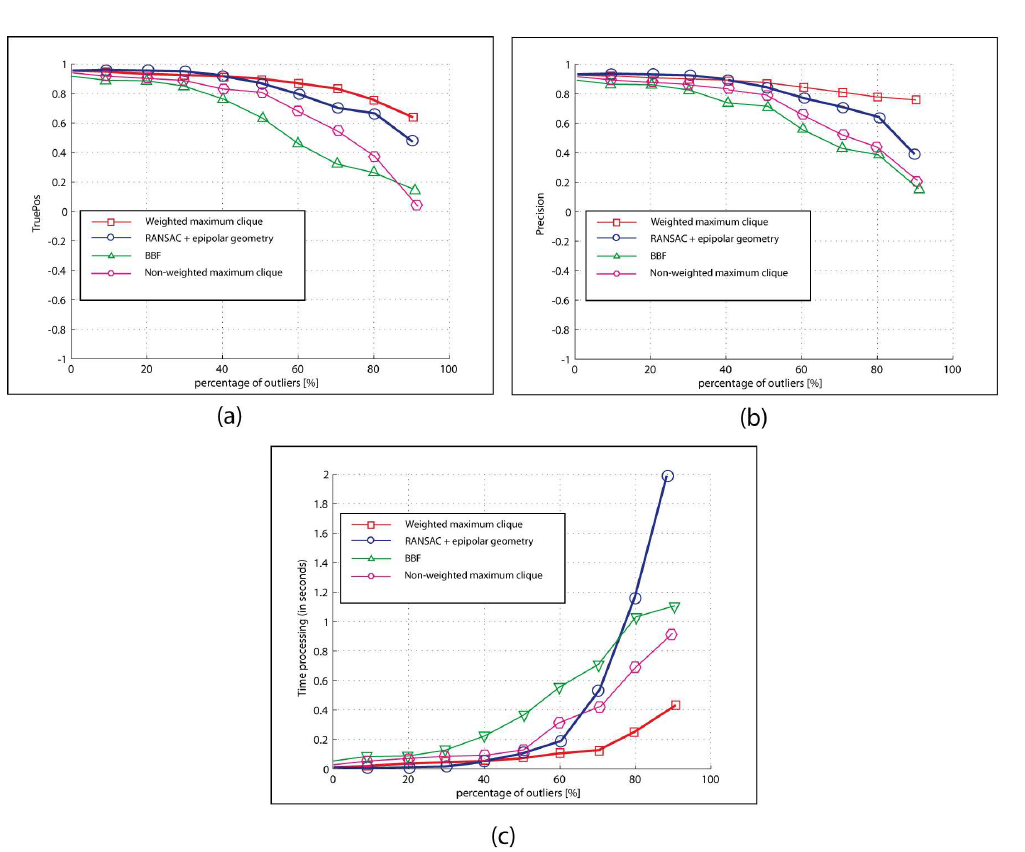
various percentage of outliers. (a) True Positives against to different percentage of outliers; (b) Evolution of the precision against to different percentage of outliers; and (c) Time processing against the percentage of outliers. See the text for more